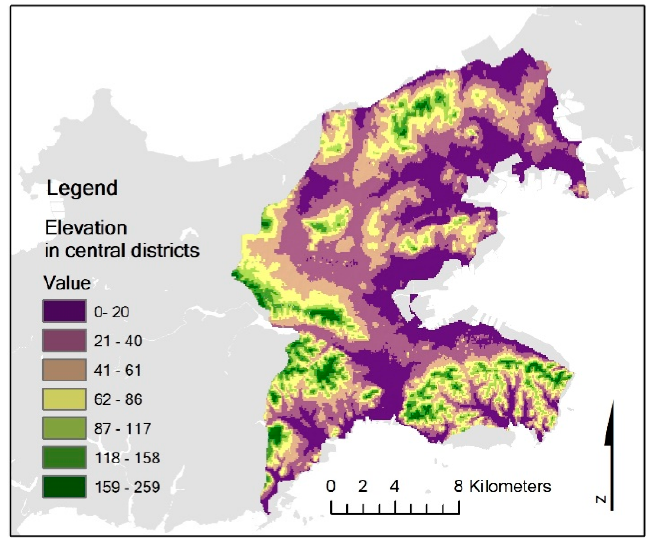
Figure 3. The slope of terrain in central districts.